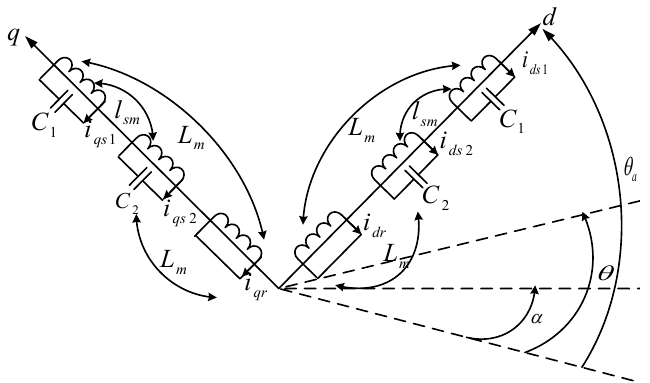
Figure 2. Equivalent model of the SPIM in the Park reference.